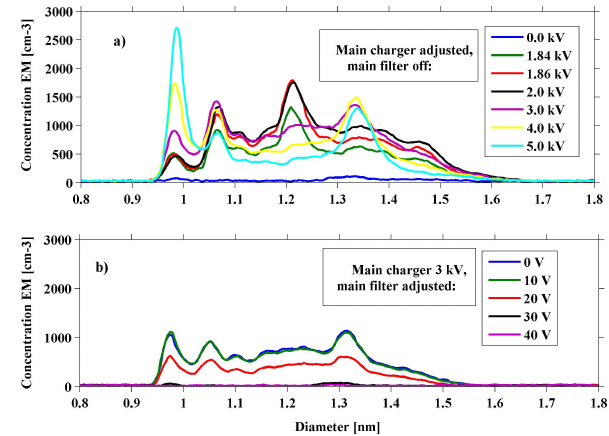
as a function of (a) negative corona voltage applied to the needle and (b) negative voltage applied to the main filter when corona voltage was kept constant at